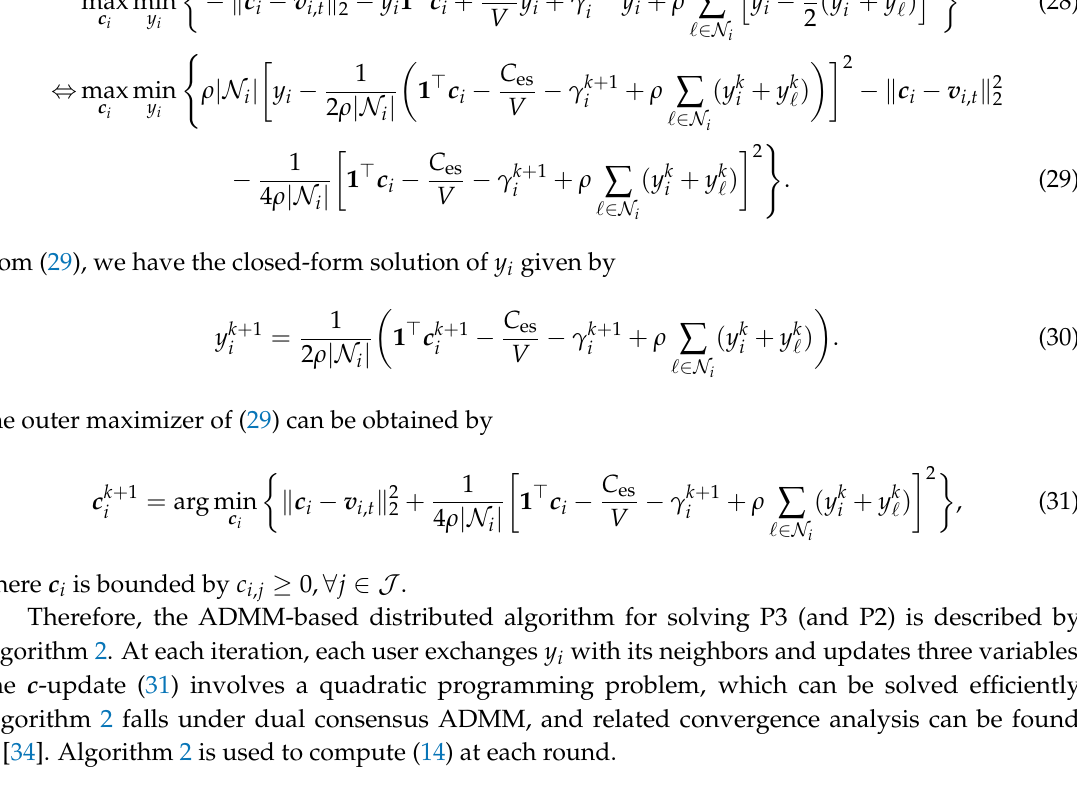
Algorithm 2: Distributed Algorithm for solving